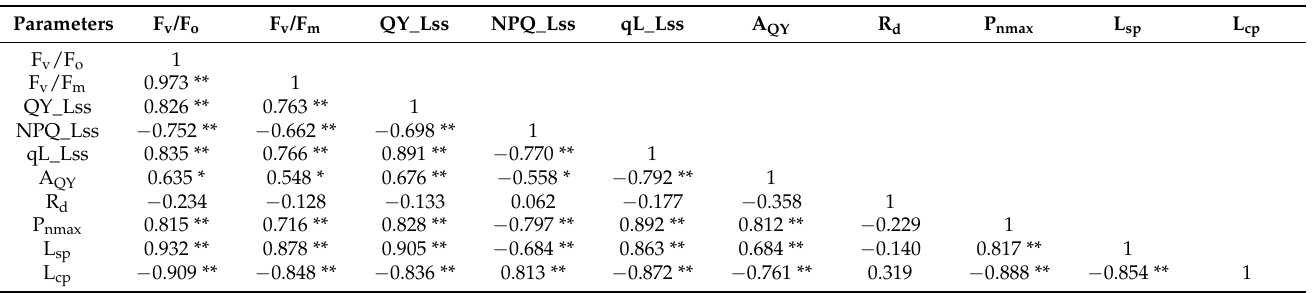
Table 4. Correlation between the characteristic parameters of the light response curves and fluores- cence